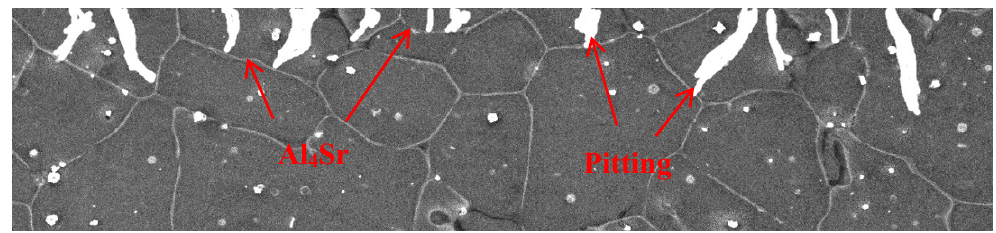
Figure 10. The polarization curves of Mg-Li alloys in 3.5% NaCl solution.